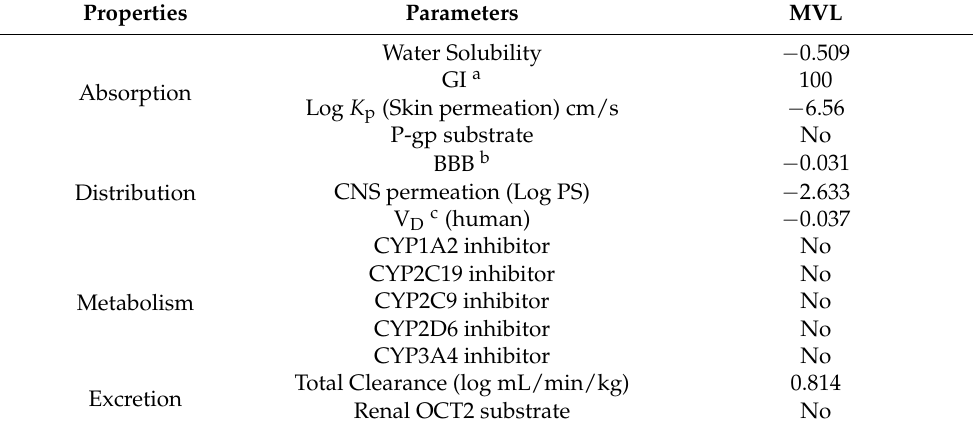
Table 5. Predicted ADME parameters of